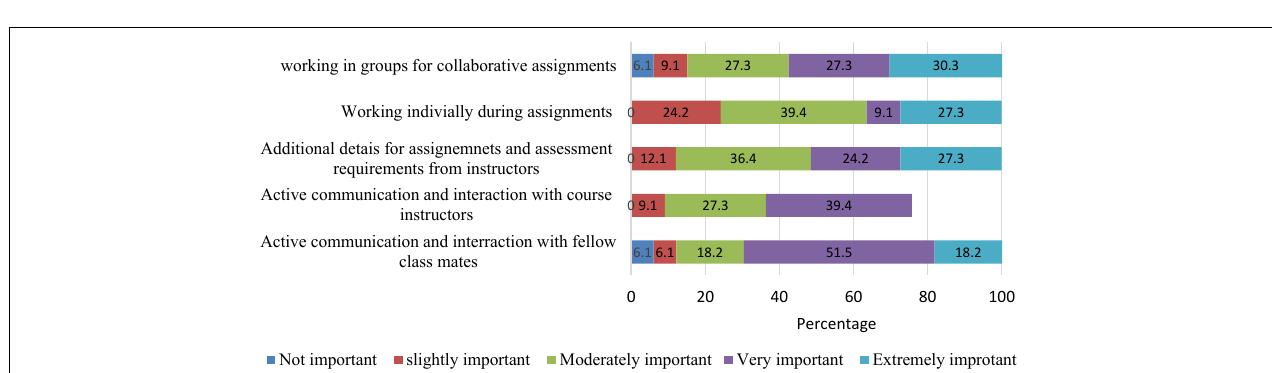
FIGURE 2 | Students’ satisfaction with participation during online learning.